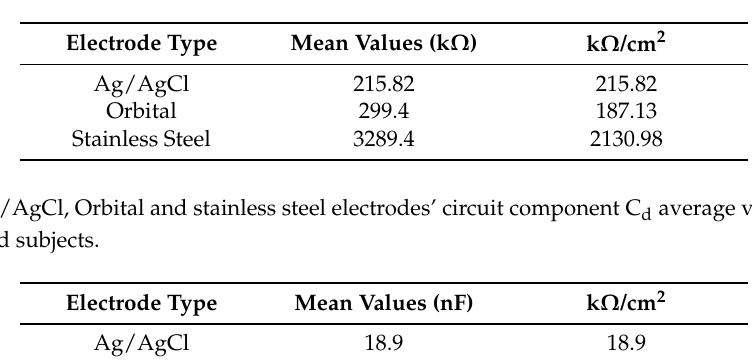
Table 2. Ag/AgCl, Orbital and stainless steel electrodes’ circuit component R d average values (k Ω ) for all the tested subjects.